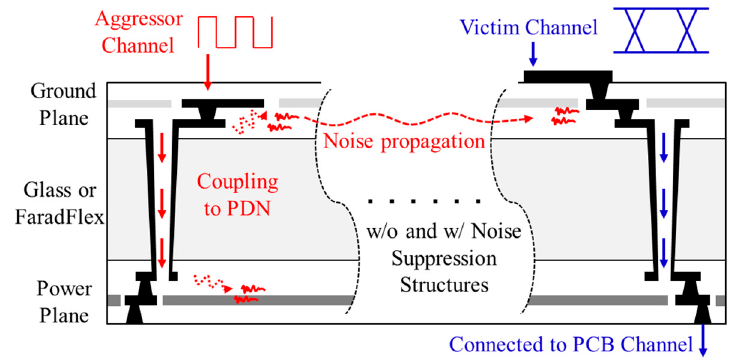
Figure 12. Graphical depiction of the simulation scenario. Aggressor channel escaping the package or interposer induces noise in the PDN. The noise propagates and couples to the victim channel. Eye diagrams of the victim channel are compared without and with noise suppression structures.